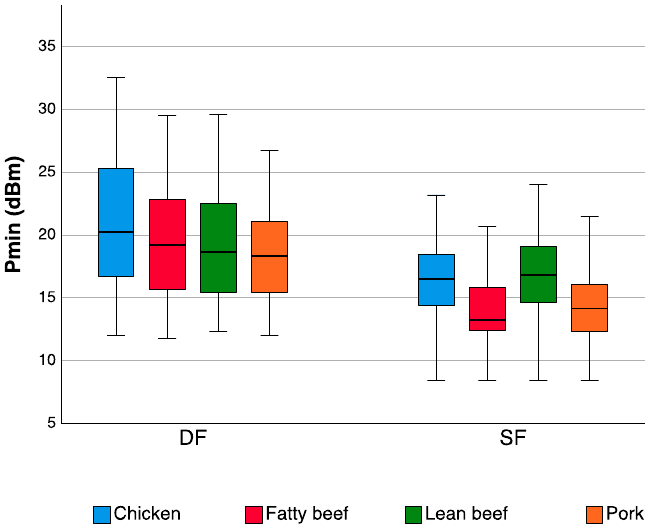
Figure 5. Comparison of the Single Frequency (SF) and Dual Frequency (DF) tag types on four meat types when detection is performed in the UHF band. The data are expressed as the minimum power required to activate the tags ( P min (dBm)) on a box-plot graph. The tag types are compared in the 2.5–18.75 mm range of distances.